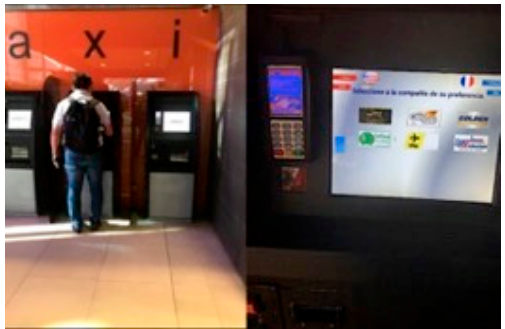
Figure 3. General overview and detailed closeup of the taxi ticketing kiosk interface in Monterrey airport, Mexico.